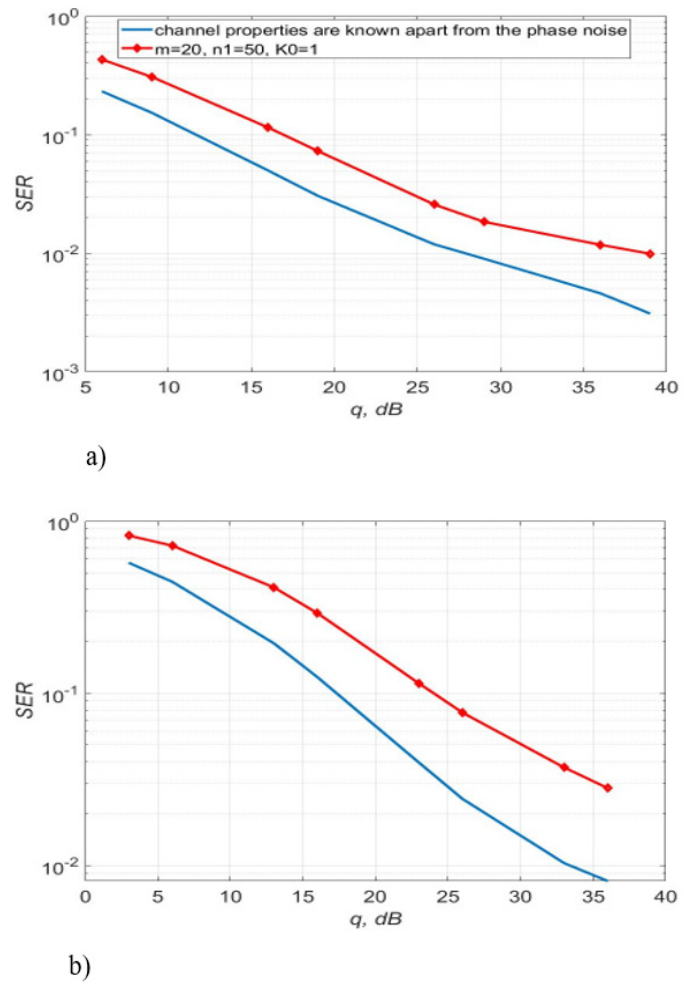
Figure 14. SER of 16-QAM ( a ), 64-QAM ( b ) versus SNR per bit: the algorithms, described by Equations (5)–(9) and (12), p = 1 .